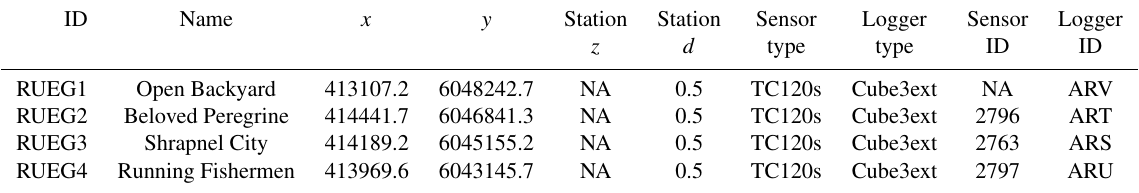
Table 1. Station information table containing all relevant metadata for the deployed seismic stations. Coordinates x and y are given in UTM coordinates (zone 33N), and station z and station d denote station elevation (ma.s.l.) and sensor deployment depth (m).